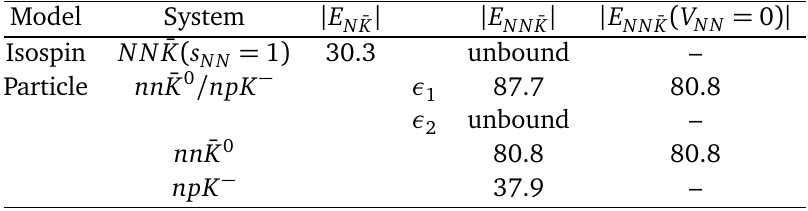
– | of the NN ¯ K ( s = 1 ) system calcu- NN NN ¯ K is the binding energy of the sin- N ¯ K ( V = 0 ) | when the interaction between NN NN ¯ K and ε are the energies of the quasi-doublet 1 2